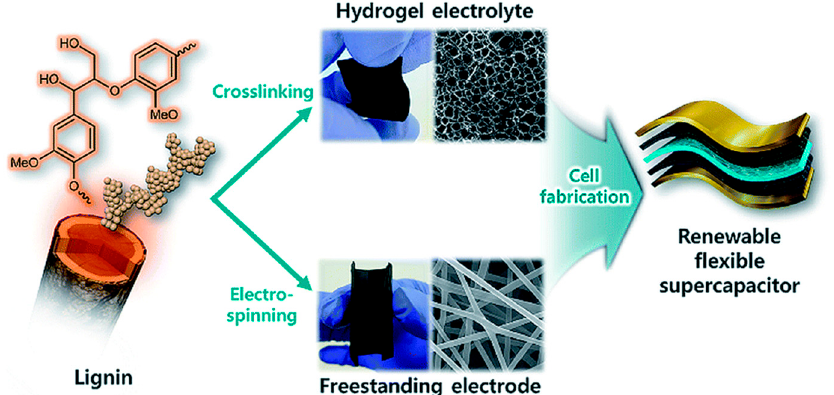
Figure 13. Scheme of the fabrication of an FSC based on an electrolyte of lignin hydrogel electrolyte and electrode of lignin/PAN/carbon nanofiber fabricated by Park et al. Reproduced from Ref. [54] with permission from The Royal Society of Chemistry. Copyright (2019) The Royal Society of